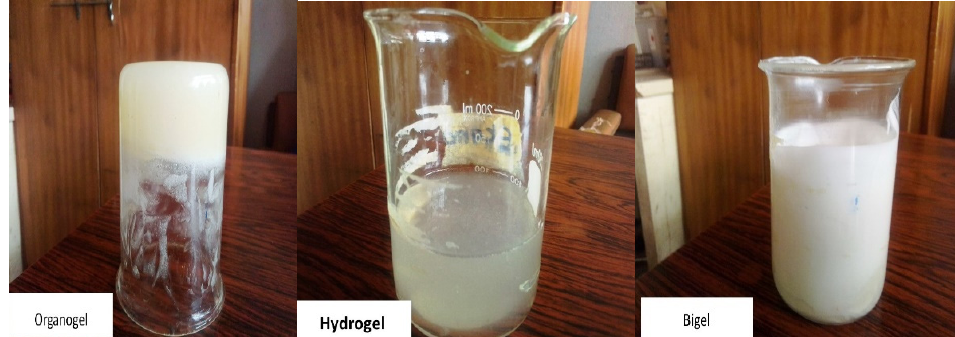
Figure 4. Organogel, hydrogel, and bigel mix. Table 5. Formulation chart for varying organogel combinations and gelation characteristics.